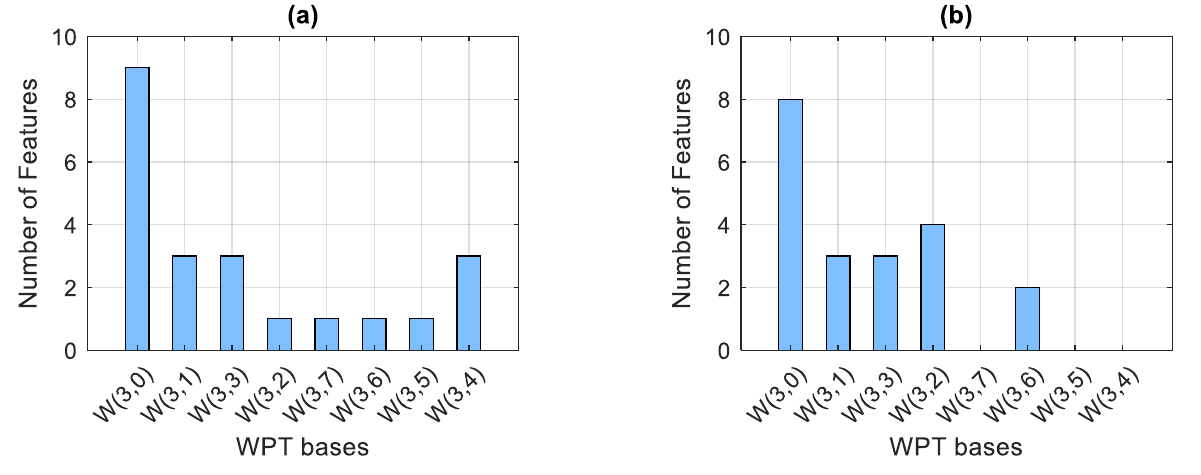
Figure 11. Number of features selected by the Boruta algorithm from each WPT node (in the ascend- ing order): ( a ) Dataset with artificial damages; ( b ) Dataset with real